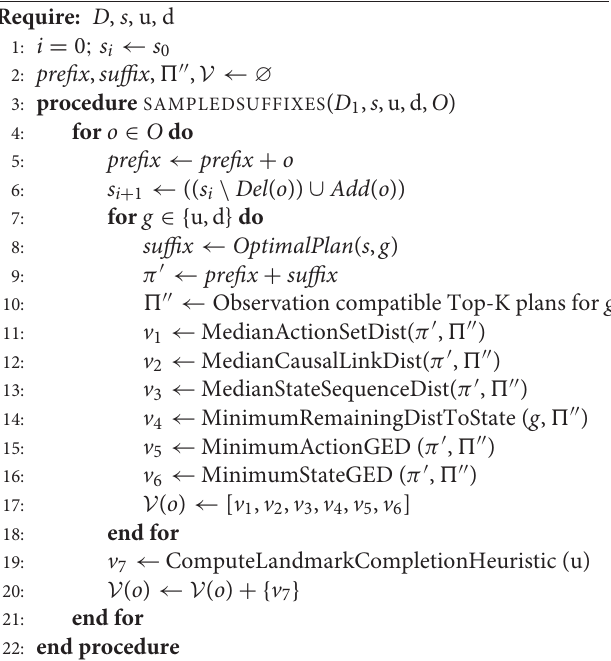
Algorithm 2 : Build Sampled Feature